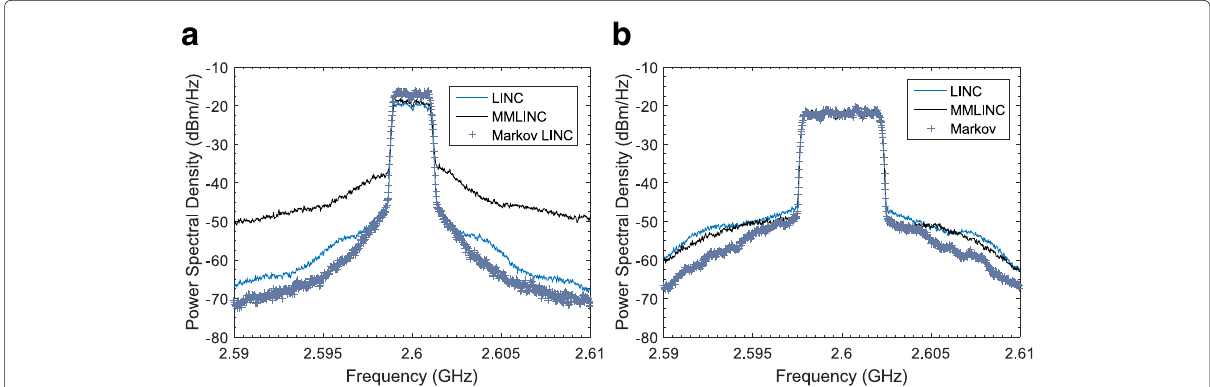
Fig. 8 Experimental performance results. Measured power spectrum densities in LINC, MM-LINC, and proposed approach (red). a OFDM 1.4 MHz and b OFDM 5